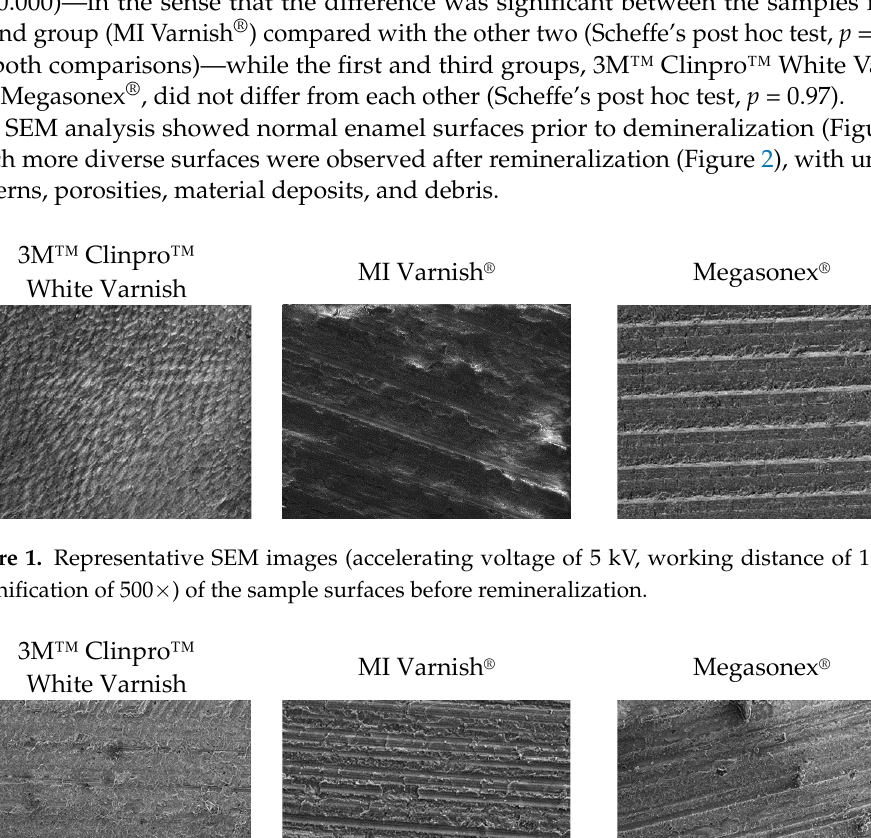
( f ) Figure 3. Representative results of EDS elemental analysis, following demineralization and remin- eralization of the samples treated with 3M™ Clinpro™ White Varnish ( a , b ), MI Varnish® ( c , d ) and Megasonex® ( e , f ).